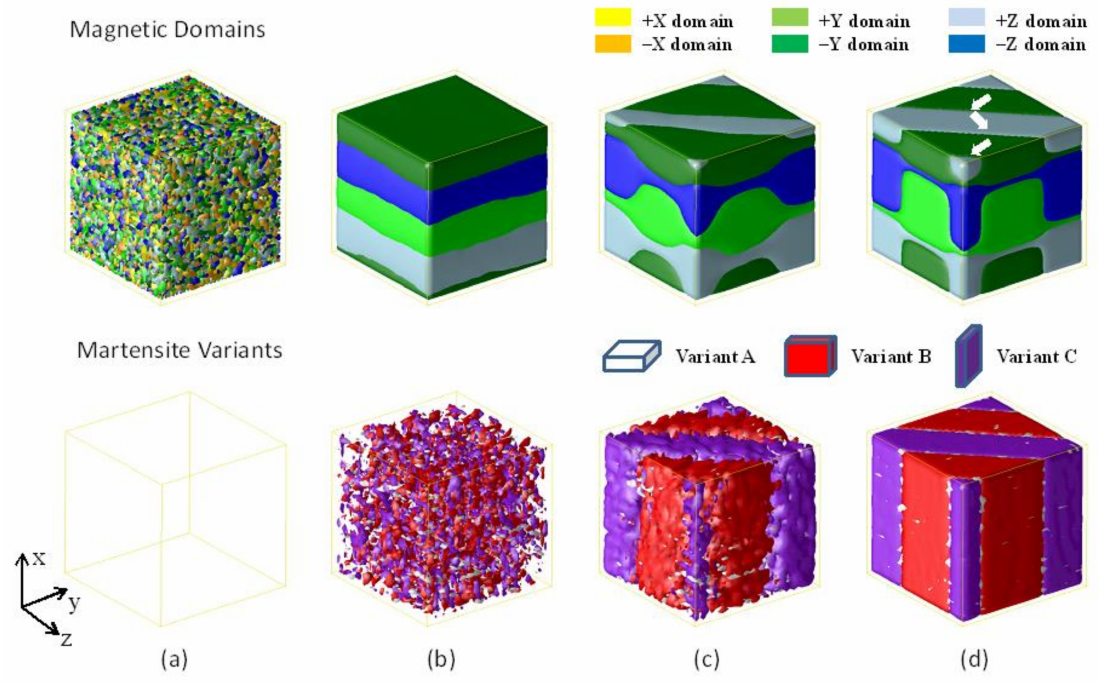
Figure 1. Temporal evolution of ferromagnetic domain morphologies and martensite variant structures with clamped boundary conditions at ( a ) 0 steps; ( b ) 10,000 steps; ( c ) 30,000 steps, at 285 K. ( d ) Final structures with stress-free boundary